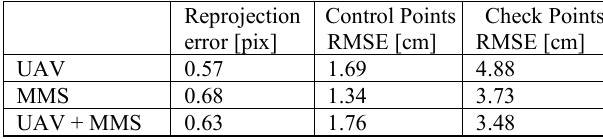
Table 5. Georeferencing accuracies: Reprojection error and RMSE in X,Y,Z for control and check points